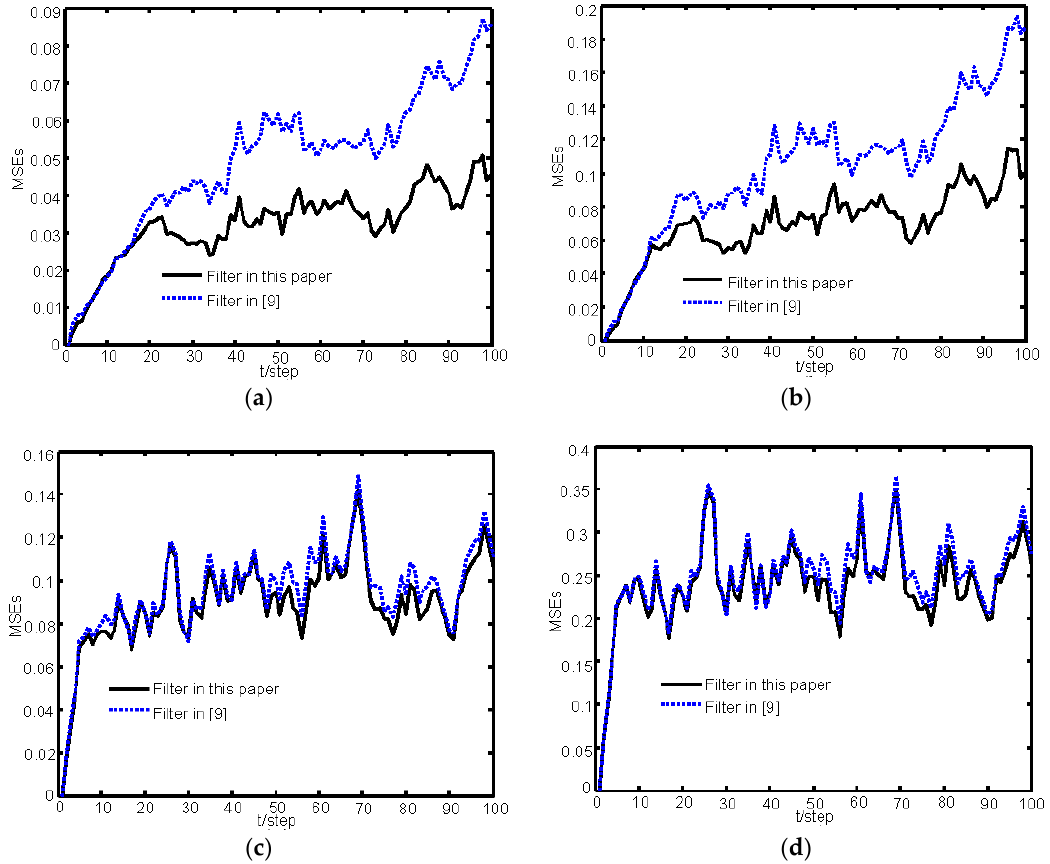
Figure 5. Comparison of MSEs of the estimators in this paper and [9] for sensor 1: ( a ) MSEs of the